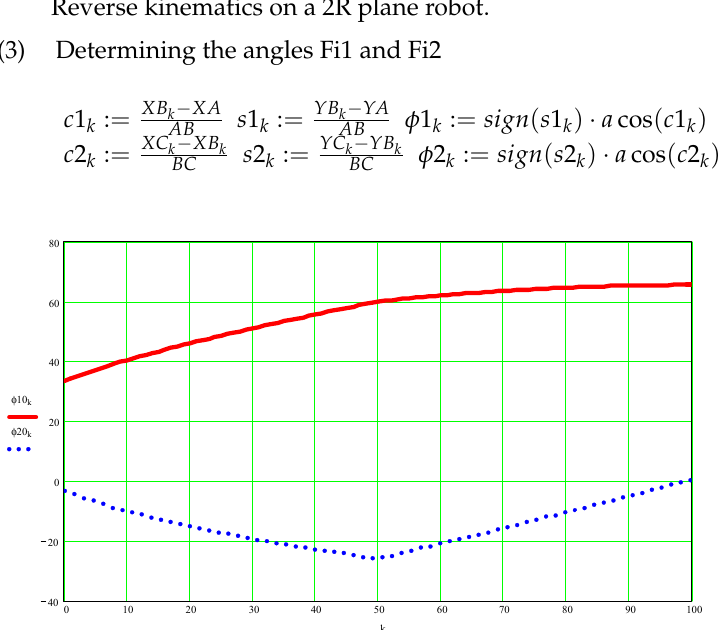
Figure A2. Scalar coordinates of kinematic coupling B as a function of the independent variable k. Reverse kinematics on a 2R plane robot.